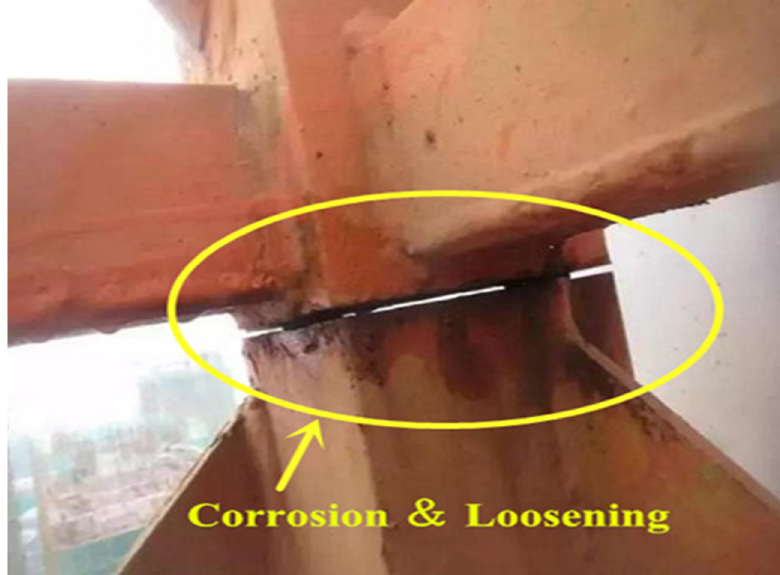
Figure 11. Corrosion and loosening.